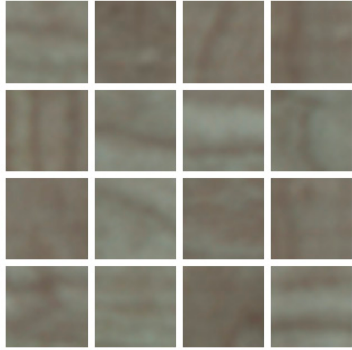
Figure 13. Collected image of the surface of a wood.